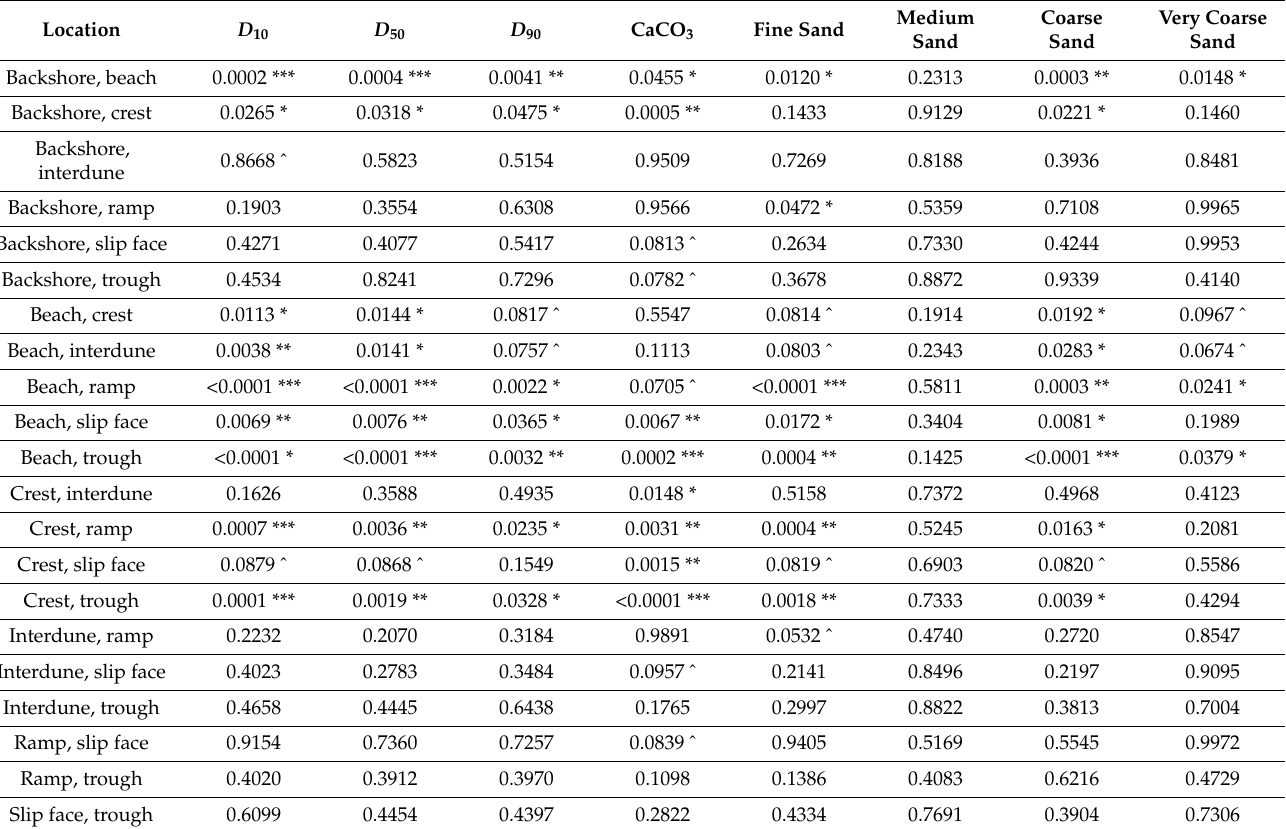
Table 2. Table of p -values obtained for different sediment properties from different sampling locations (Table 1), analysed using Fisher’s partial least squares discriminant analysis. Significance levels